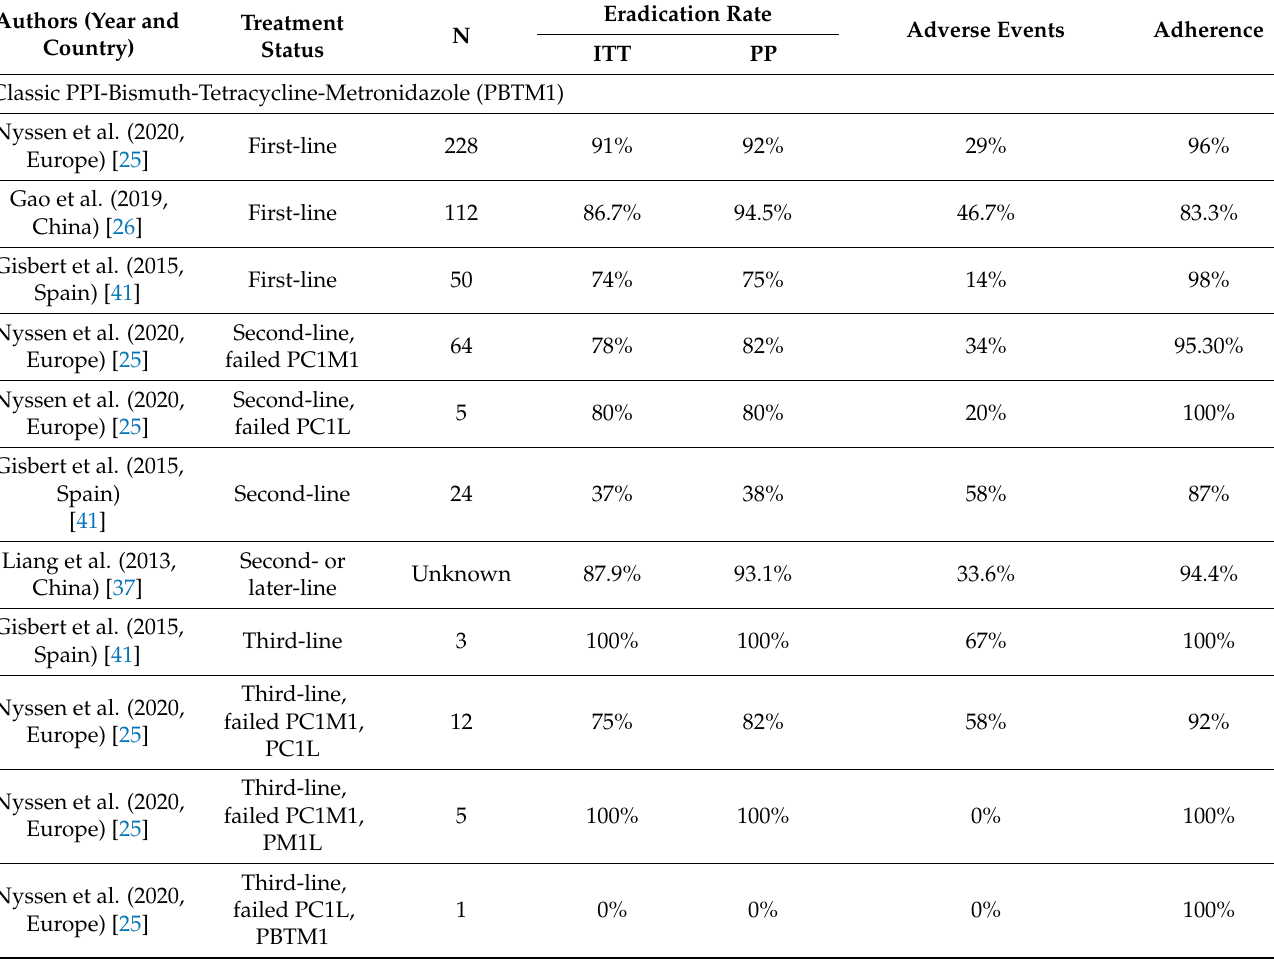
Table 4. Results of Bismuth quadruple therapy for Helicobacter pylori infection